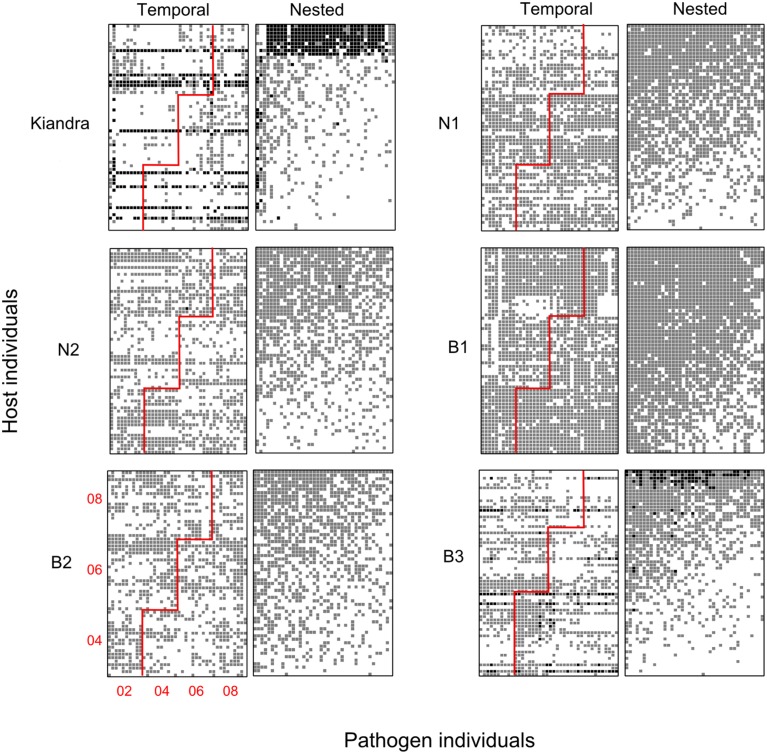
Bipartite networks for the Linum-Melampsora temporal datasets. Black squares indicate full resistance, gray squares indicate partial resistance, and white squares indicate full susceptibility. Each pair of panels represents a separate population/temporal network (labeled Kiandra, N1, etc.). The two columns for each population pair are formed from the same base dataset but sorted in different ways so as to facilitate visually testing different evolutionary hypotheses. The left panels have been sorted according to sampling period (i.e., temporally), while the panels to the right have been sorted to maximize nestedness. For the temporally sorted networks, the red line demarks contemporary host and pathogens, such that an interactions above and to the left of the red line indicate hosts interacting with past pathogens (year of sampling is shown in the bottom left panel). The expectation under an arms race hypothesis is that there should be a nested pattern emerging over time, such that more resistance reactions occur above and to the left of the red line. All networks were significantly nested when sorted to maximize nestedness (Table 3: NODF; P < 0.05), but none were significantly nested under the temporal arrangement.